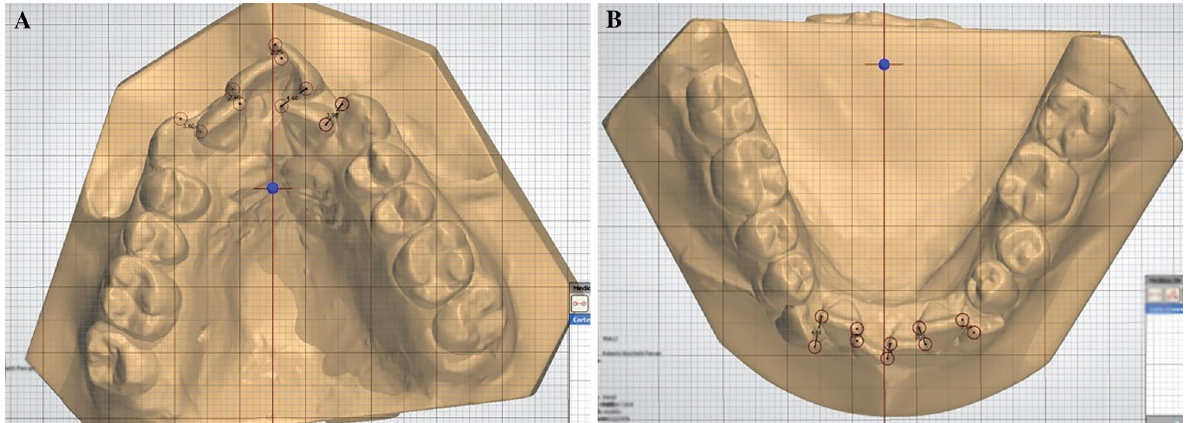
Fig. 1 A Measurement of maxillary Little’s irregularity index. B Measurement of mandibular Little’s irregularity index